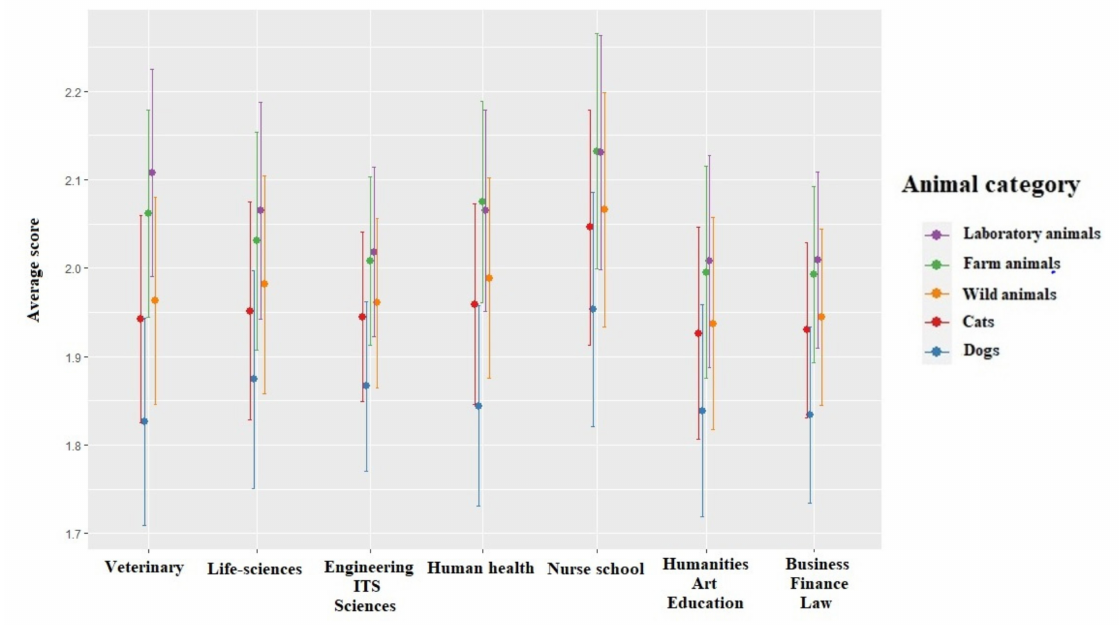
Figure 3. Means and 95% confidence intervals of scores towards the animal Sentient model depending on the students’ major and the animal class. Means and confidence intervals have been back- transformed from a log scale, but 95% confidence intervals are presented on the log